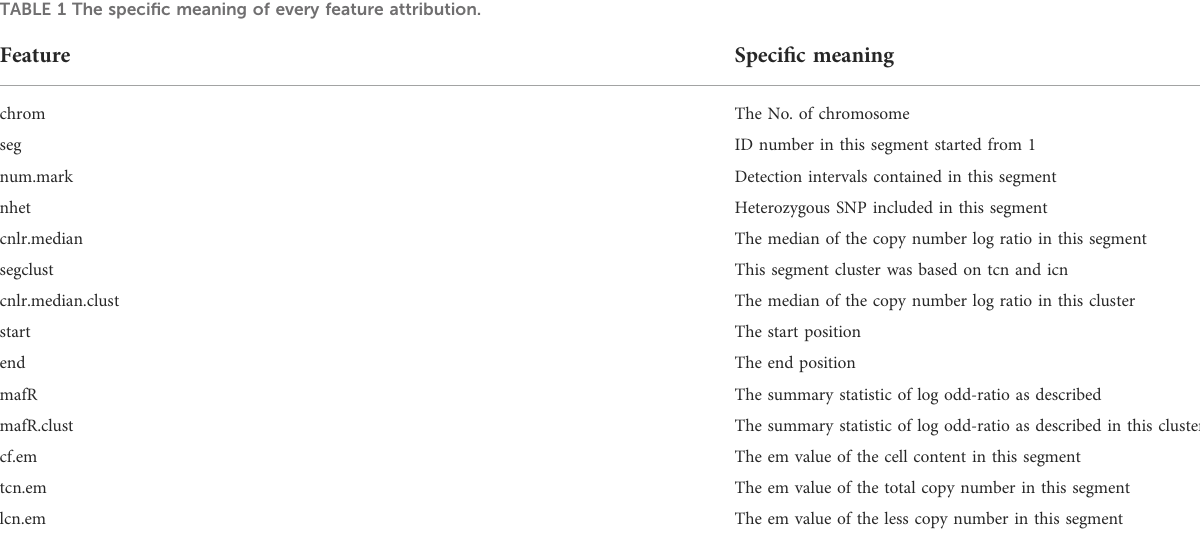
TABLE 1 The speci fi c meaning of every feature